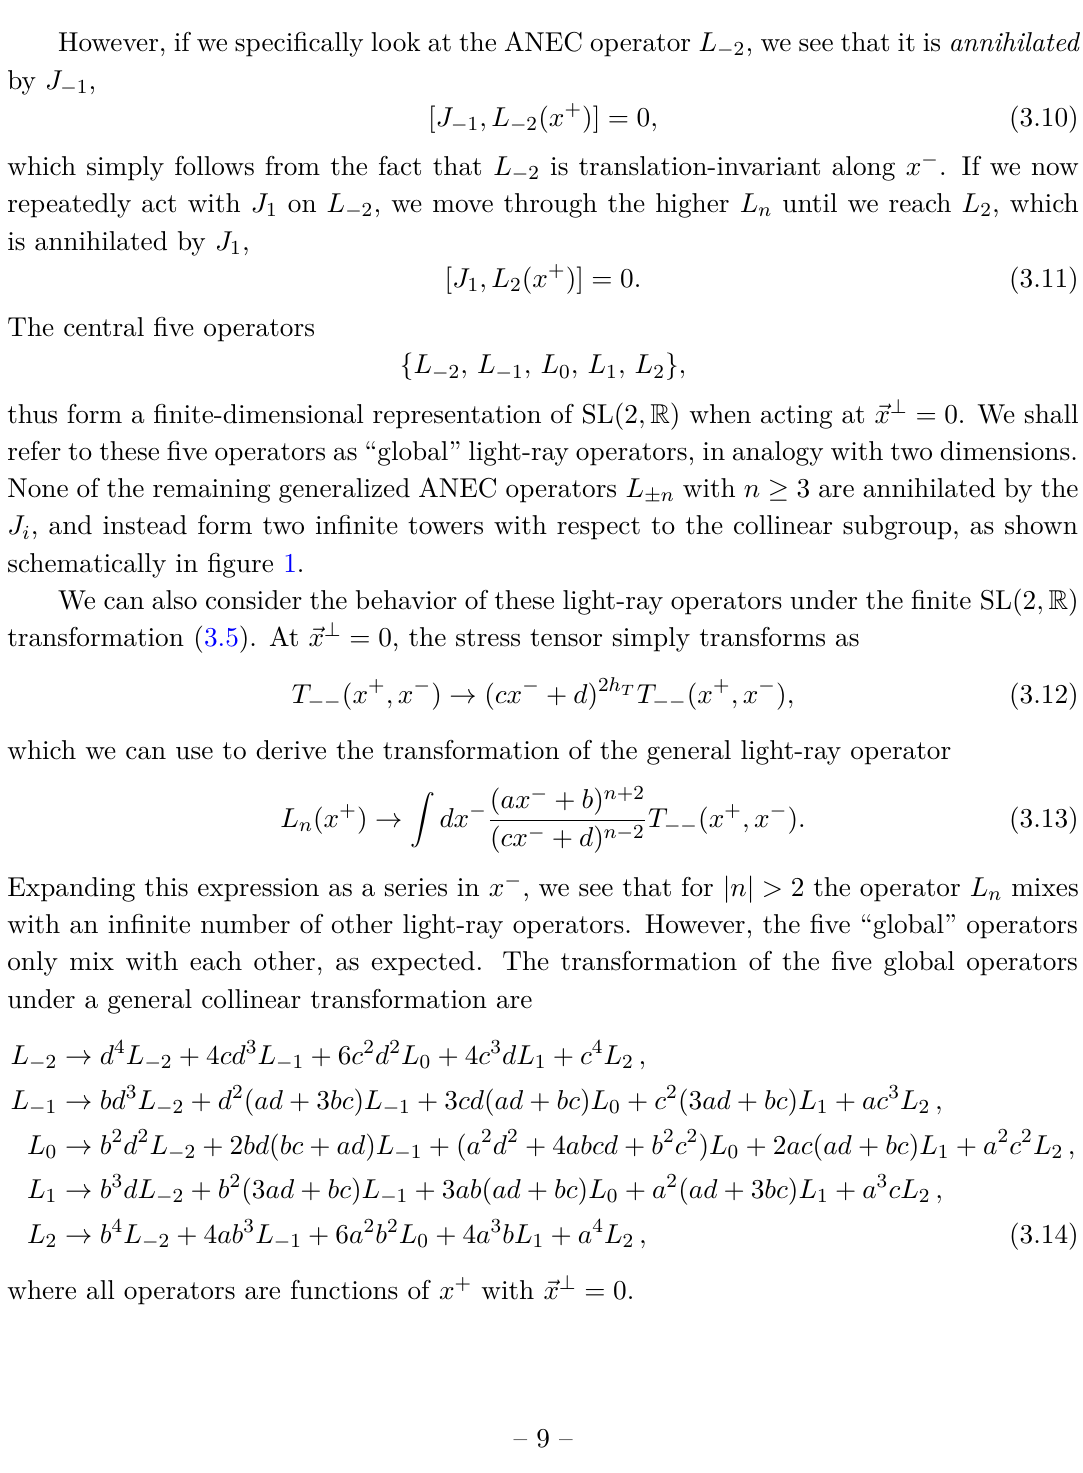
Figure 1 . Schematic representation of the action of the collinear generators J ± 1 on the light-ray operators L n . The “global” operators with n = {− 2 , − 1 , 0 , 1 , 2 } form a five-dimensional represen- tation of SL(2 , R ) , with the remaining operators in two infinite